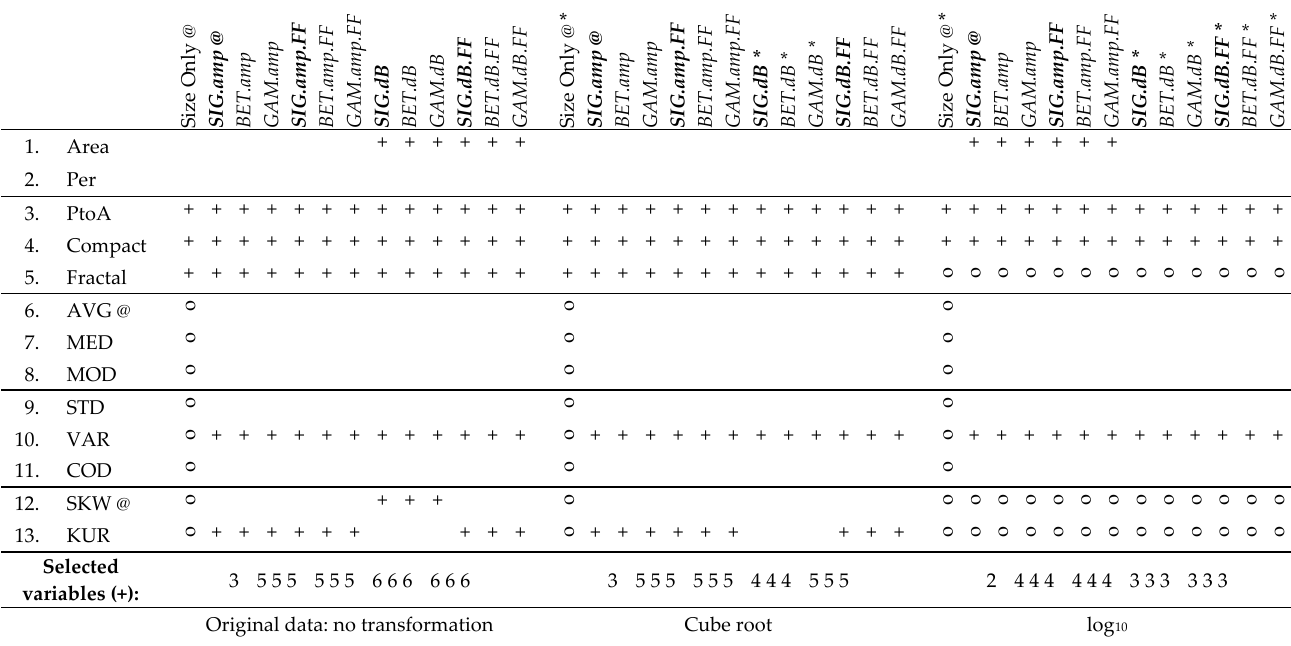
explanation and Figure 5 for visualization. (o) Variables not accounted for (see Section